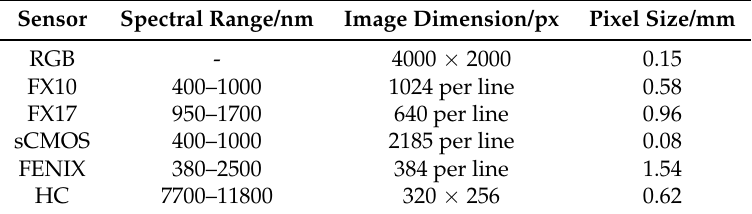
Table 1. Specifications and settings used for the hyperspectral sensors and the RGB cameras. The pixel size is expressed in the length of a quadratic pixel.